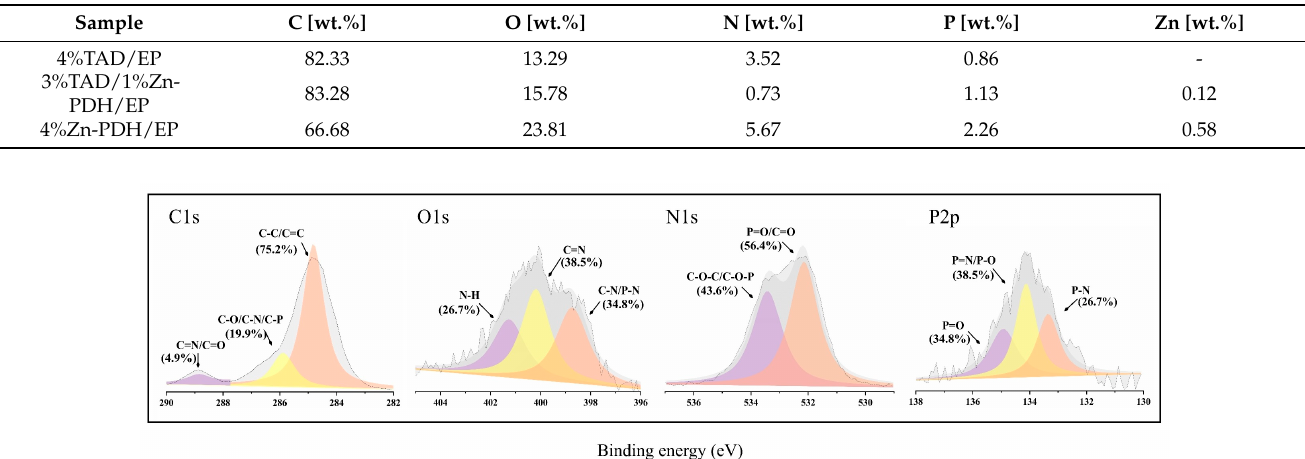
Table 6. Carbon residue data of EP composites after cone size test from XPS.